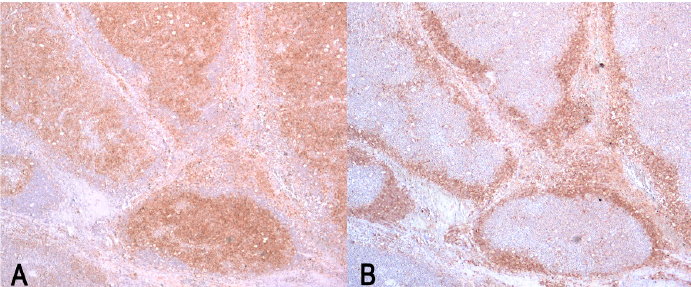
The neoplastic cells were strongly positive for CD79 α and were negative for CD3 (Figure 3).